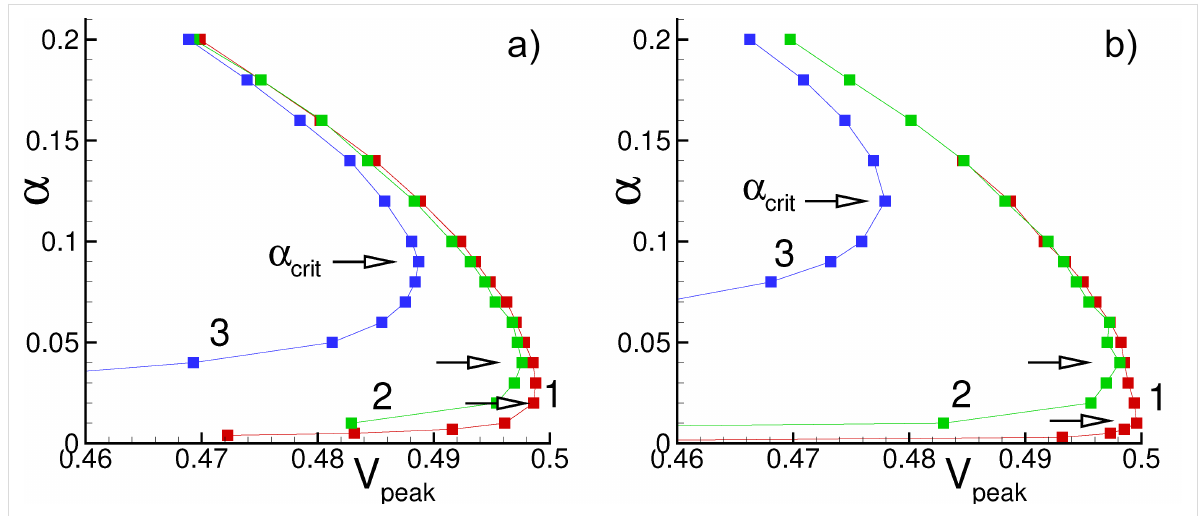
Figure 4: (a) Demonstration of ADD at different values of SOC parameter r at G = 0.05. Numbers indicate: 1 – r = 0.05; 2 – r = 0.1; 3 – r = 0.5; Arrows show critical α value, corresponded to the reversal in the α dependence. (b) Demonstration of ADD at different values of the Josephson-to-magnetic energy ratio G at r = 0.05. Numbers indicate: 1 – G = 0.01; 2 – G = 0.1; 3 – G = 1.